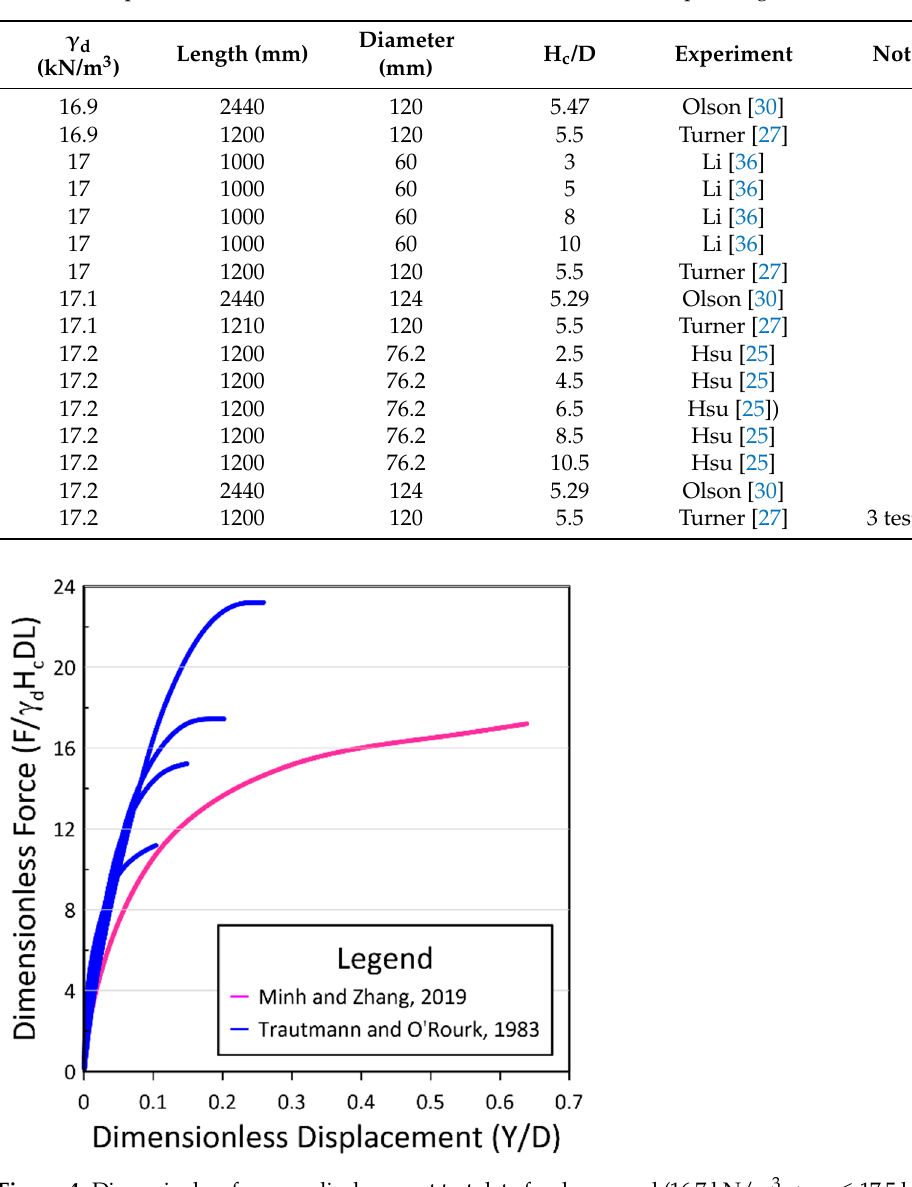
Table 2. The parameters used for each dense sand test with the corresponding researcher.